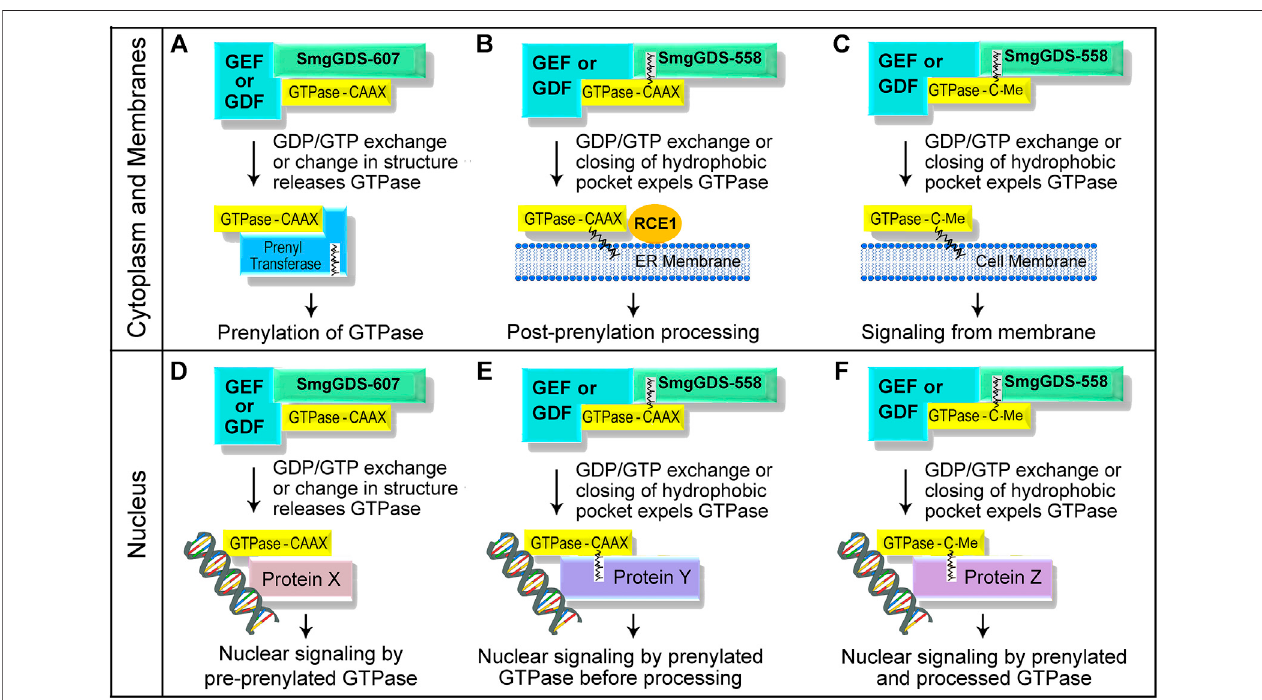
FIGURE 3 | Schematic illustration depicting how unidenti fi ed GEFs and GDFs might release small GTPases from SmgGDS splice variants in the cytoplasm and at membranes (A – C) , and in the nucleus (D – F) . The interactions of these proteins with SmgGDS will control when the small GTPases will be prenylated or undergo post- prenylation processing, and determine where the small GTPases will localize in the